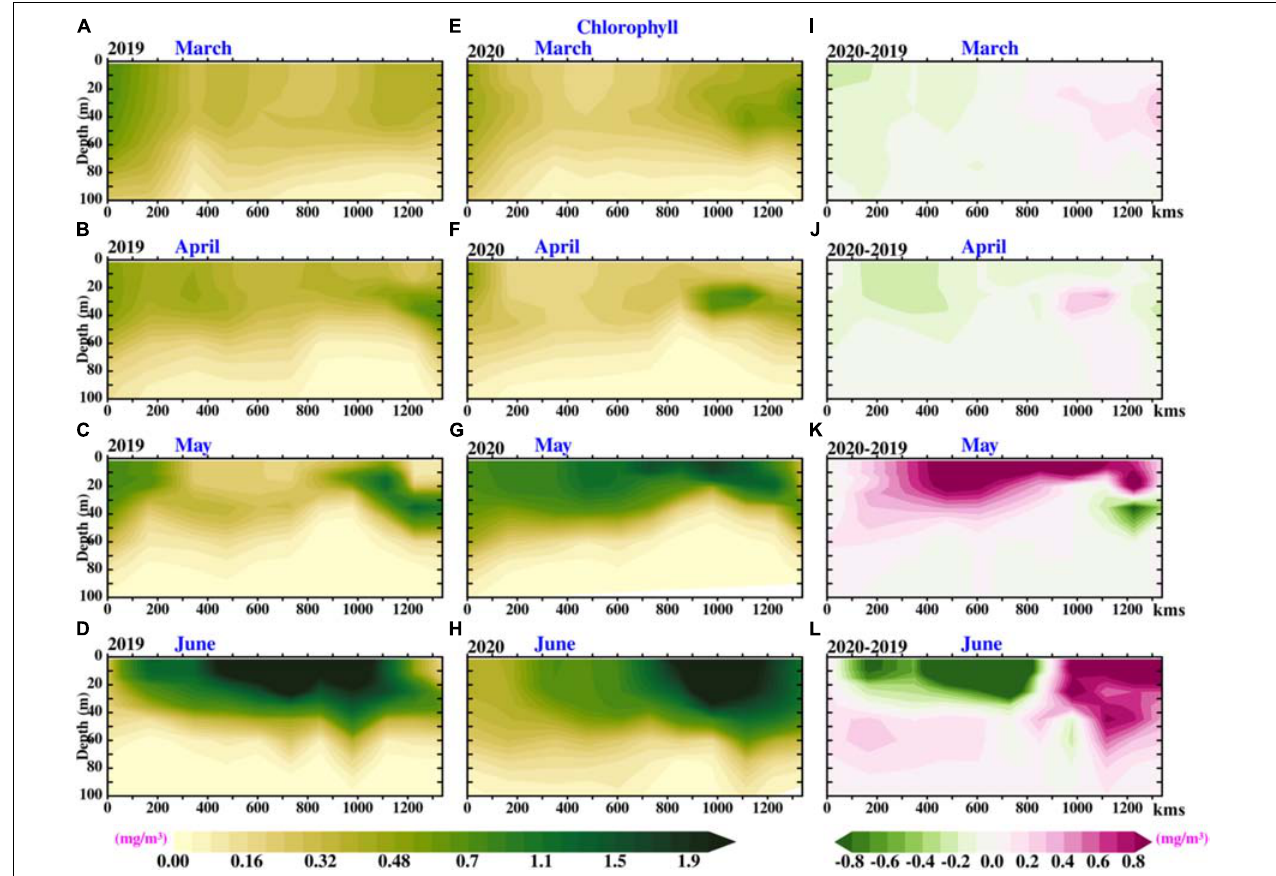
FIGURE 15 | Evolution of model-simulated Chl-a concentration along the 1,000 m isobath off Somalia coast (as shown in Figure 1 ), (A–D) during the pre-pandemic period (March–June 2019), (E–H) pandemic period (March–June, 2020), and (I–L) Chl-a concentration of 2019 are subtracted from 2020 with respected months